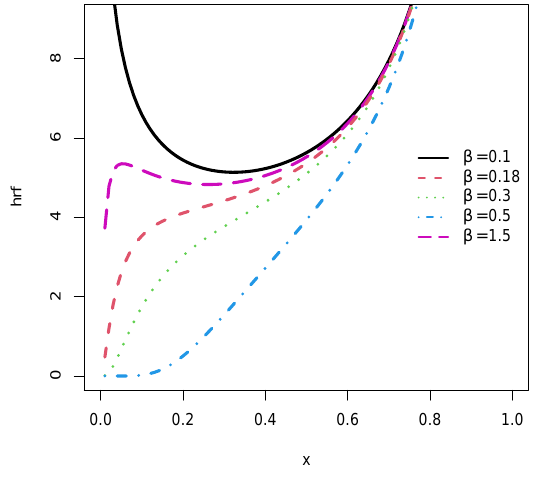
Figure 3. Several curves of the hrf of the unit-Rayleigh